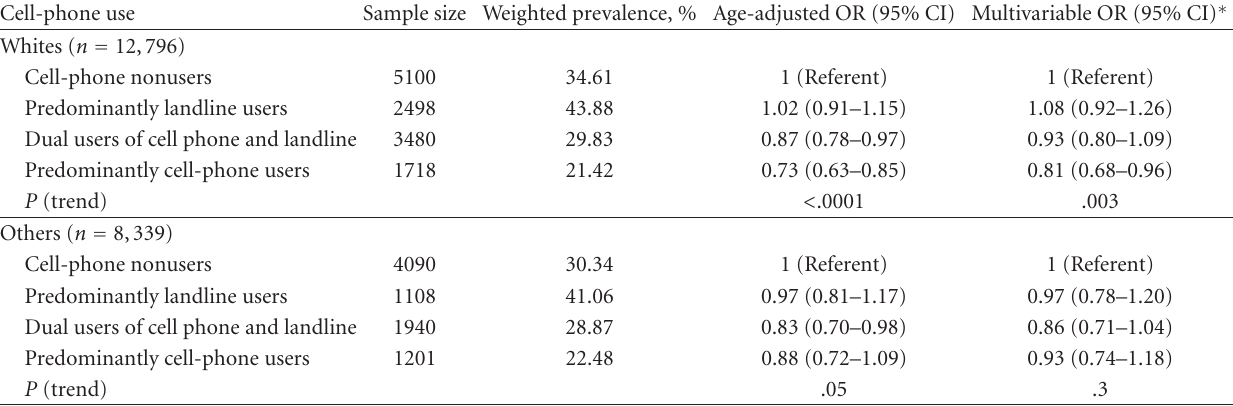
Table 5: Association between cell-phone use and hypertension by race/ethnicity.